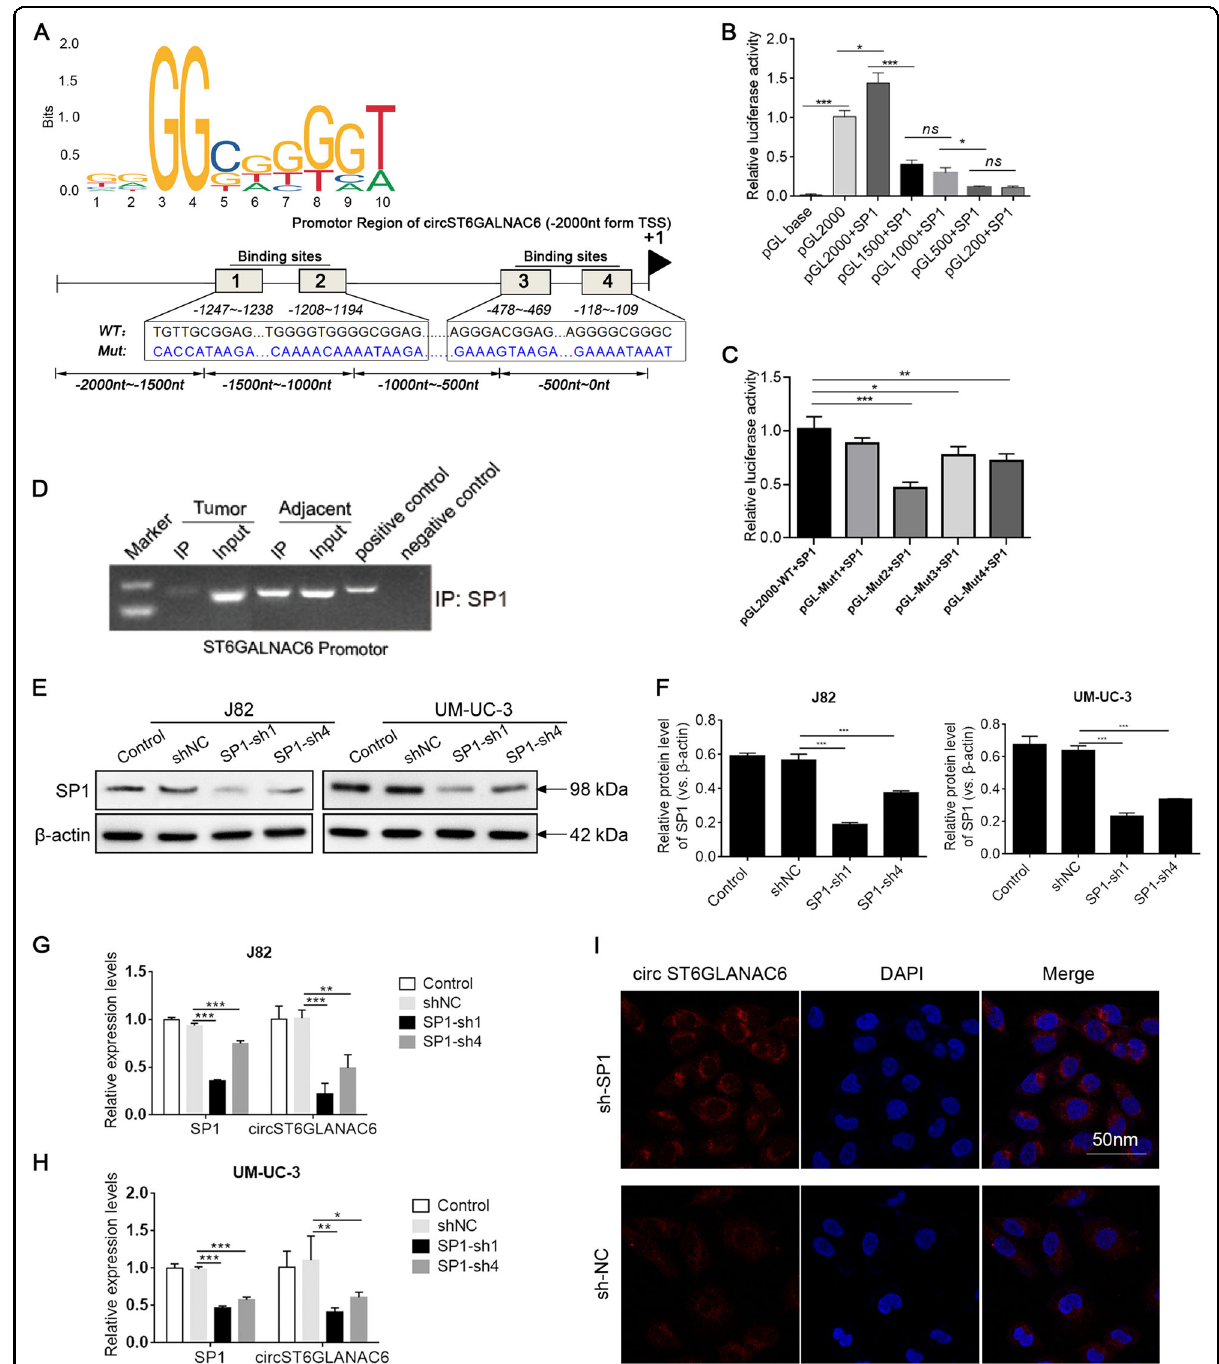
Fig. 3 SP1 bound to the circST6GALNAC6 promoter and activated its transcription. A Schematic representation of the binding region of SP1 speci fi c to the promoter of circST6GALNAC6. B A luciferase reporter assay was performed to detect the activity of circST6GALNAC6 in 293T cells co-transfected with SP1. The fi re fl y luciferase activity of each sample has been normalized by the Renilla luciferase activity and has been presented as percentage activity of the pGL-base containing SV40 promoter. C The dual luciferase reporter assay was used to detect the transcription activity of pGL2000WT + SP1, pGL-Mut1 + SP1, pGL-Mut2 + SP1, pGL-Mut3 + SP1, pGL-Mut4 + SP1. The fi re fl y luciferase activity of each sample has been presented as percentage activity of the pGL2000WT + SP1. D ChIP-PCR was used to analyse the binding of SP1 with the circST6GALNAC6 promoter in bladder cancer tissues and normal tissues. E , F SP1 protein levels were detected by western blotting in cells transfected with NC or SP1 shRNA. G , H Relative SP1 and circST6GALNAC6 mRNA levels in cells transfected with NC or SP1 shRNA were measured using qRT-PCR. I circST6GALNAC6 expression was measured by FISH in cells transfected with NC or SP1 shRNA. *** P < 0.001, ** P < 0.01 and * P <